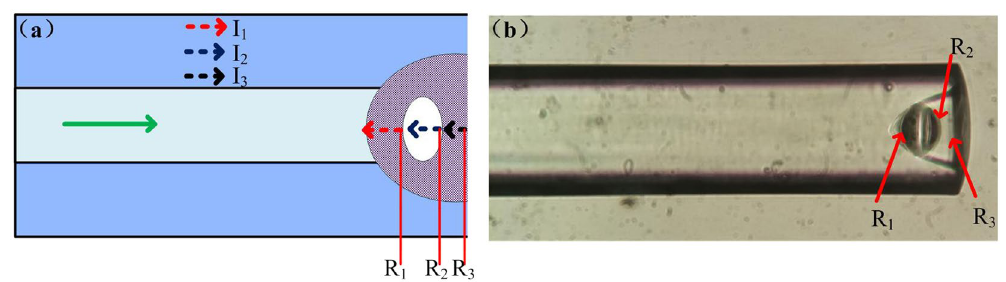
Figure 2. ( a ) Schematic diagram and ( b ) the microscope image of the sensor